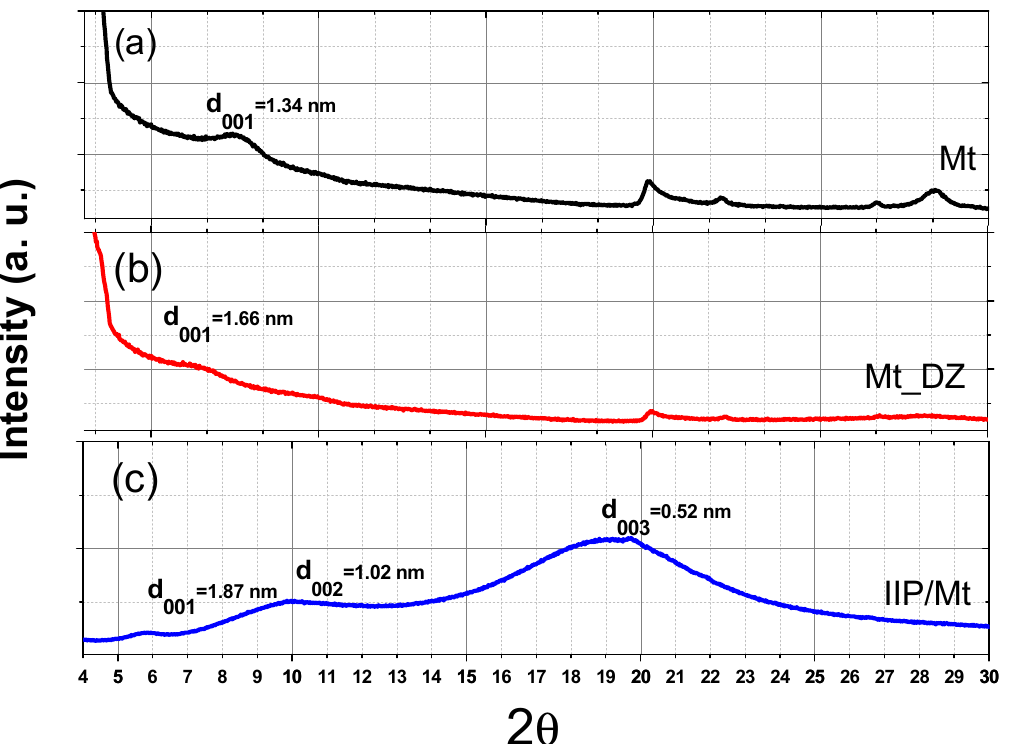
Figure 1. XRD patterns of montmorillonite Mt ( a ), Mt_DZ ( b ) and IIP/Mt ( c ) nanocomposite.